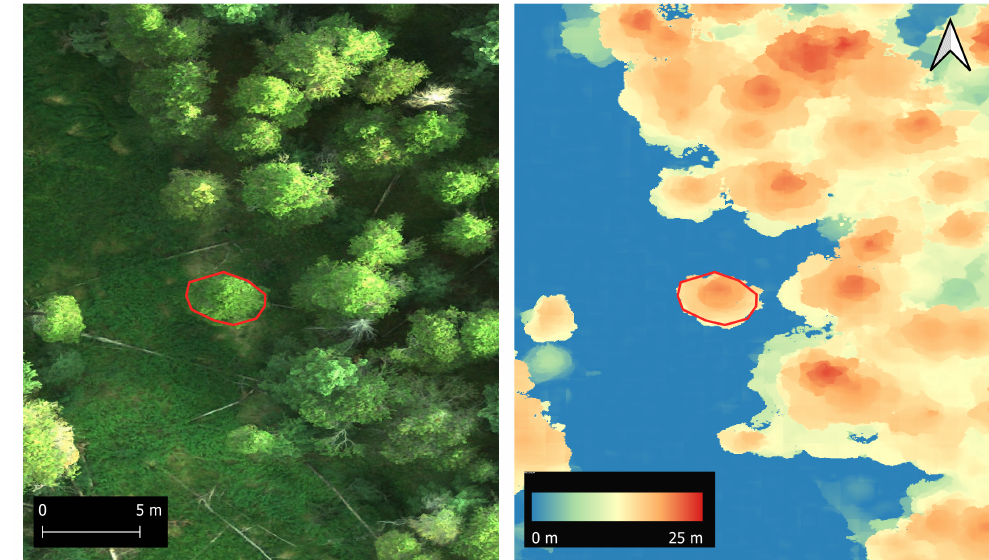
Figure 2. Details from an orthophoto ( left ) and canopy height model ( right ). The red polygon shows the outline of the crown of a lodgepole pine that was manually delineated for height